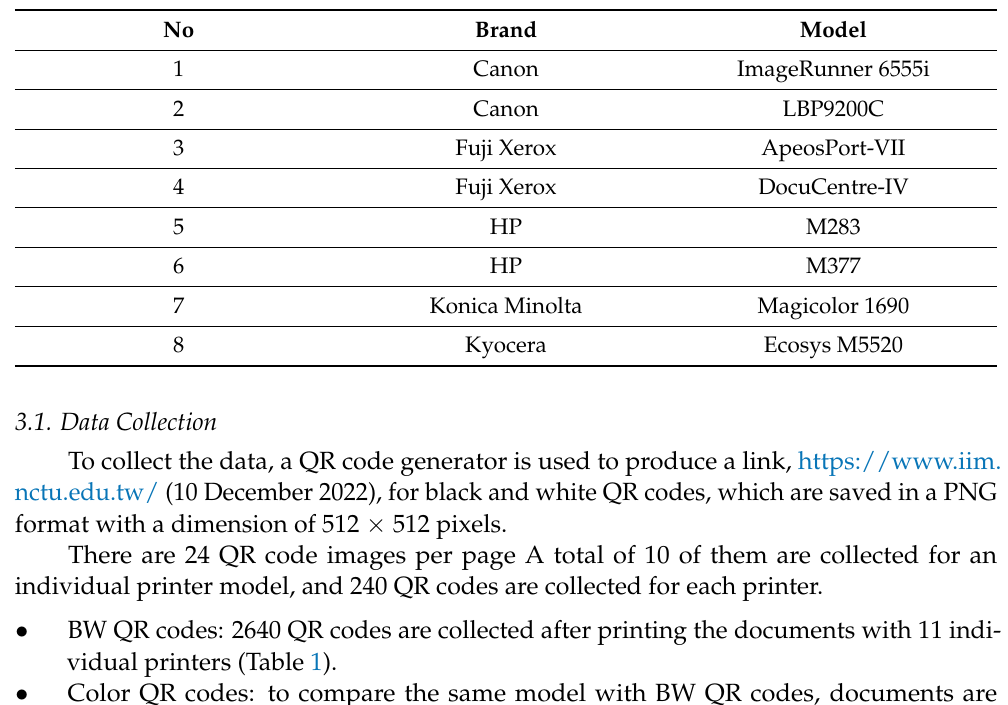
Table 2. Printer Brand and Model List (Color QR